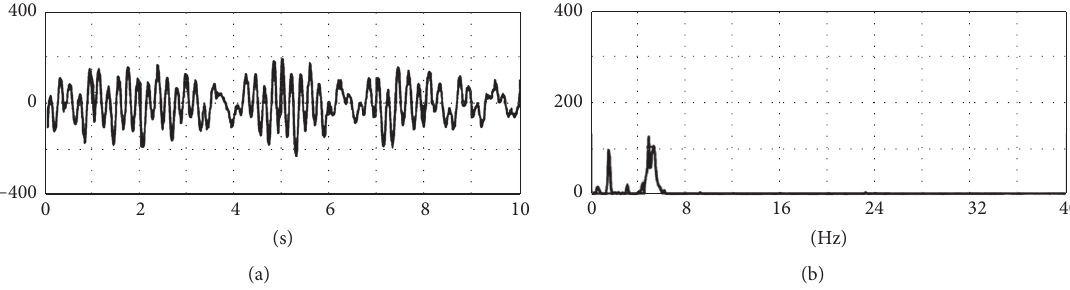
Figure 10: Shaft vibration at the TJB of a LHG with 530 MW, in time (a) and frequency (b) domains (spectrum main peaks are